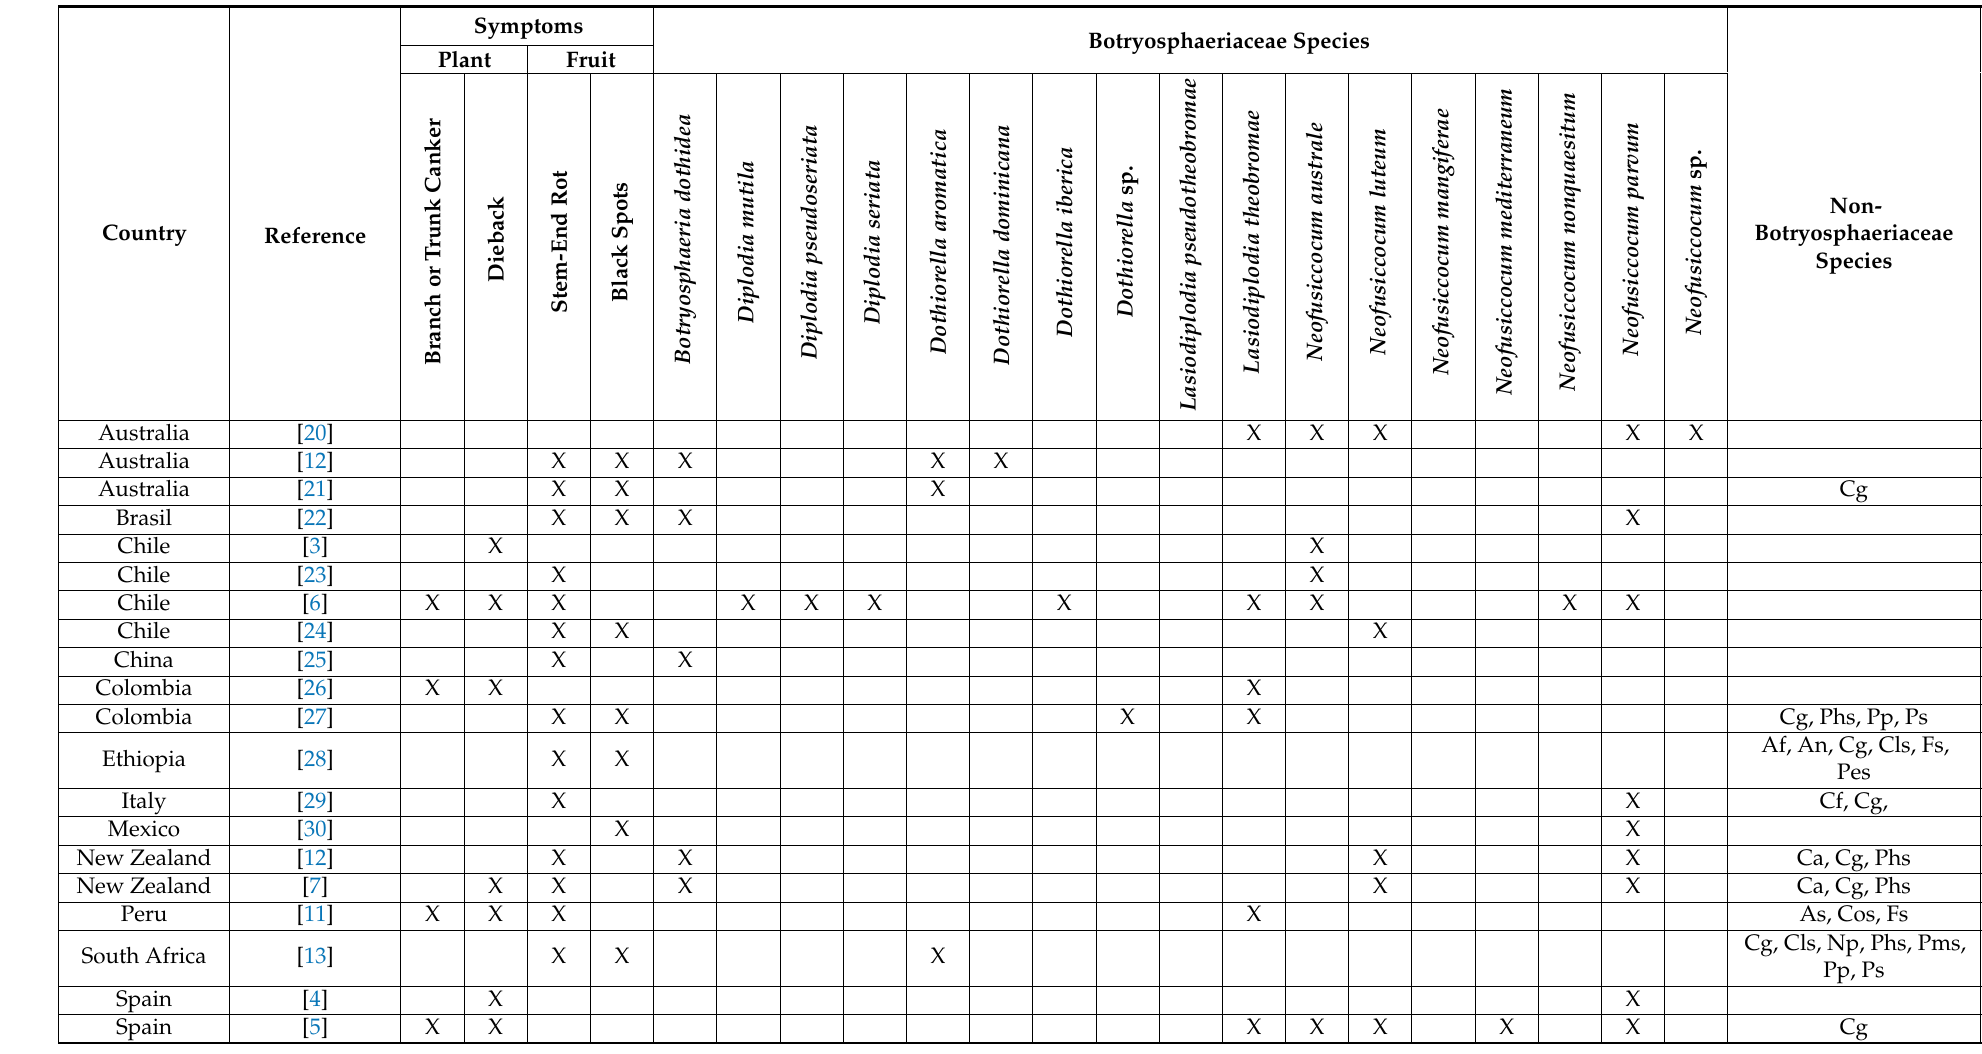
Table 1. Fungal species isolated from avocado plants or fruits showing symptoms usually attributed to fungi of the Botryosphaeriaceae